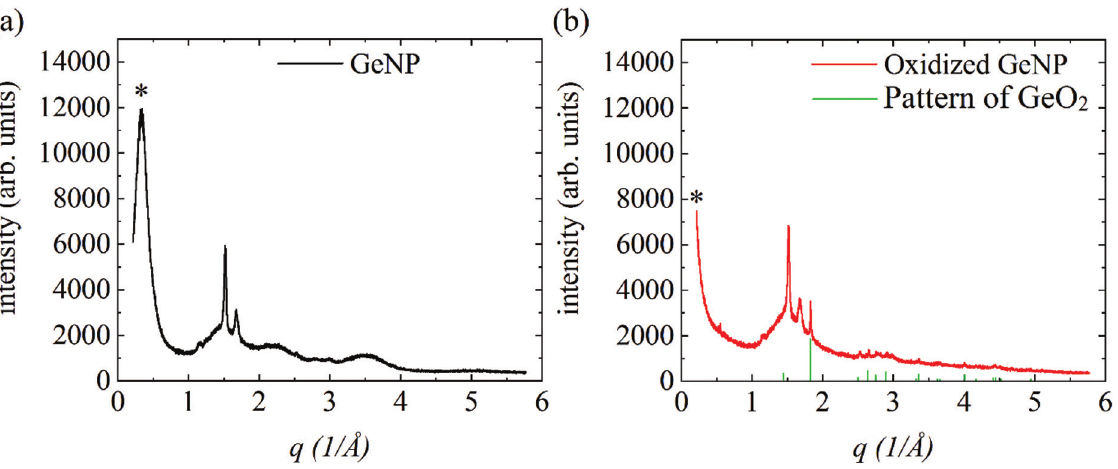
Figure 3: (a) Powder XRD pattern of germanium nanoparticles. The star marks particle-particle correlations (see text). (b) Powder XRD pattern of germanium nanoparticles denotes the reflections of GeO GeO (PDF # 03-065-6772). The peaks at q = 1.5 and q = 1.7 belong to a crystalline phase of unknown 2